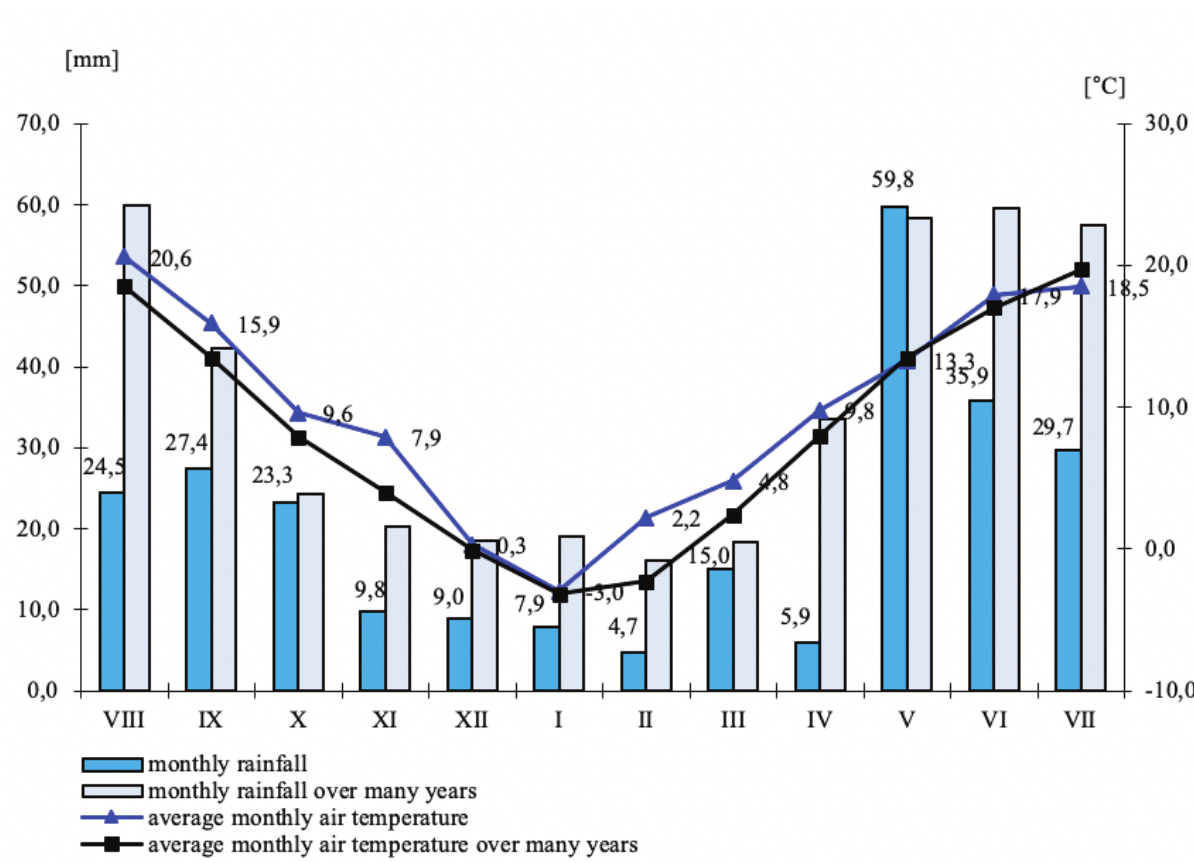
Figur e 4: Monthly rainfall totals and average air temperature during the growing season 2018-2019 in RSD Zawady of many years